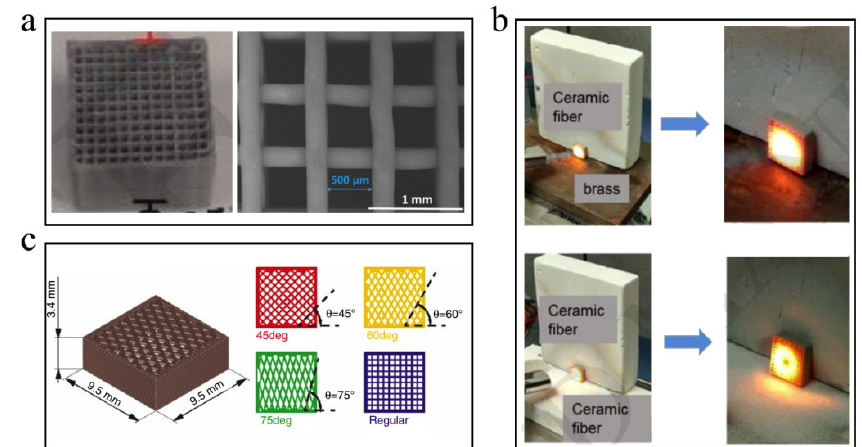
Fig. 20 EFF of SiC ceramic : (a) highly-porous hierarchical SiC structures; (b) thermal protection application; (c) effects of rod orientation. Reproduced with permission from Ref. [71], © SECV 2020.